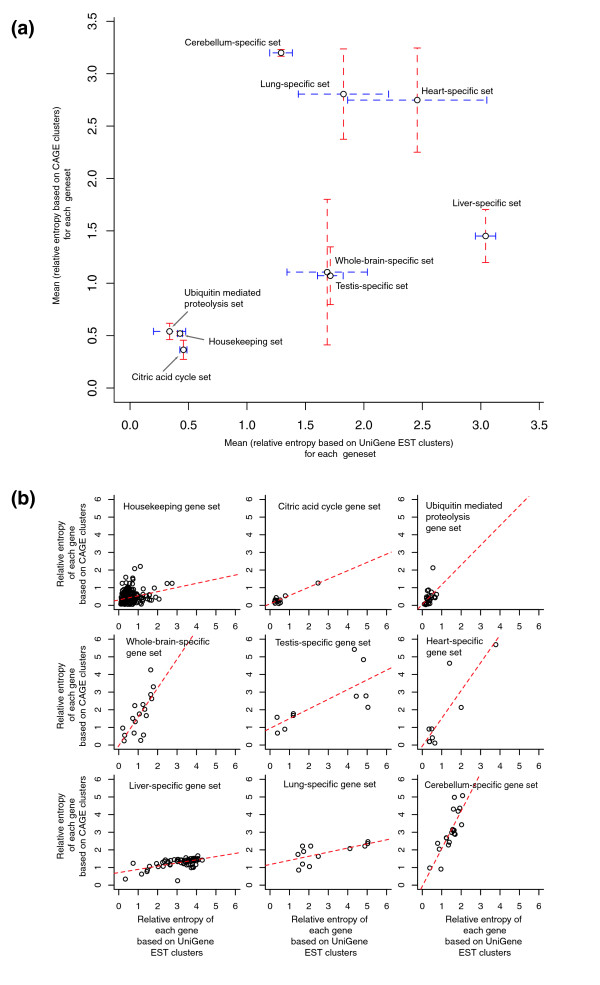
Tissue specificity measured by relative entropy. (a) Tissue specificity correlation between EST and CAGE data sources, measured as the mean relative entropy in each of the nine gene sets. Standard error bars for CAGE (red) and EST (blue) are shown. The plots of the six tissue-specific sets are distinct from the three ubiquitously expressed sets. (b) Tissue specificity correlation between EST and CAGE data sources, using the tissue specificity (relative entropy) of individual genes in each set. Spearman correlation coefficients and associated P values rejecting the null hypothesis (no correlation) are shown in Table 1. CAGE, cap analysis of gene expression; EST, expressed sequence tag.